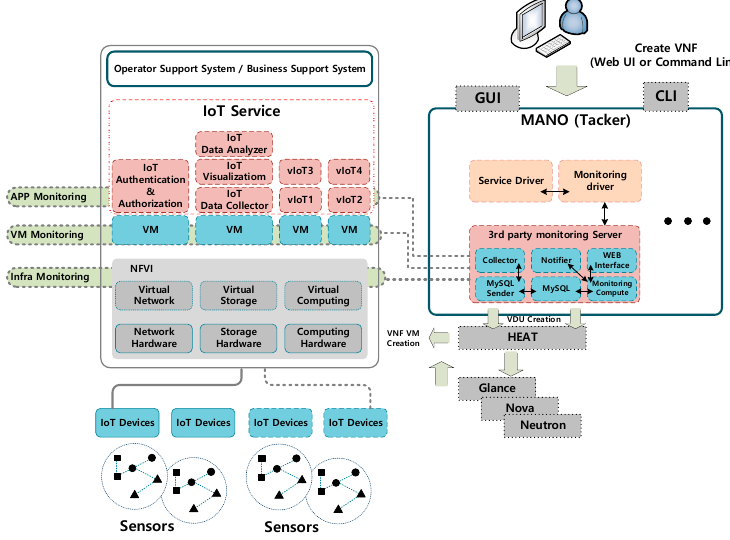
Figure 1. High-availability architecture for IoT-cloud .